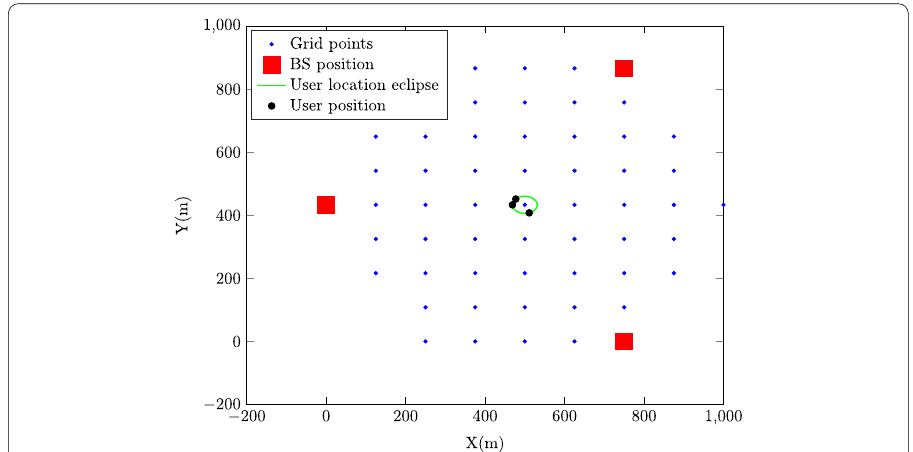
Fig. 4 The hexagon in the middle of the cells denotes the cluster area under consideration where the users are located at the cluster